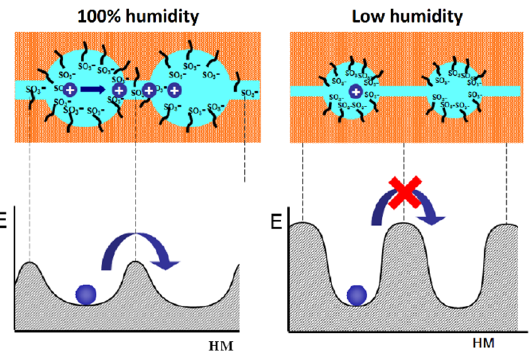
Figure 1. Schematic representation of the cluster Gierke model. Left is maximum humidity. Right is low humidity.